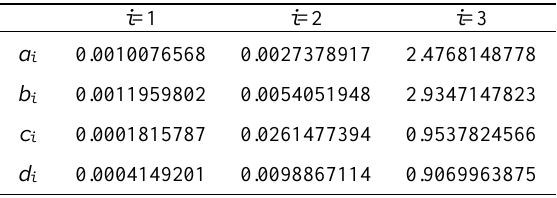
Table 1. Parameters of quadratic curve